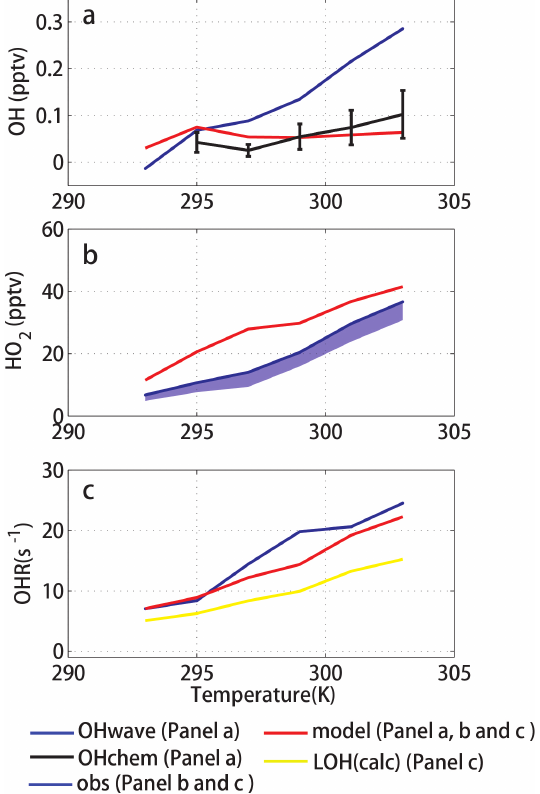
Fig. 5. Temperature dependence of (a) daytime measured and mod- eled OH, (b) daytime measured and modeled HO 2 , and (c) OH re- activity between 9:00 and 15:00PST during BEARPEX09. In (a) , OHwave (blue line), OHchem (black line) and modeled OH (red line) agree at low temperature, but OHwave has a significant tem- perature increase while OHchem and modeled OH show little tem- perature dependence. The vertical bars indicate a combined uncer- tainty as described in Fig. 2. Note that OHchem here is corrected by 0.80 to account for the removal of internal OH by C 3 F 6 addi- tion (see supplemental material). In (b) , measured HO 2 (blue line) is lower than modeled HO 2 (red line) but not significantly at the low and high temperatures. Measured HO 2 may be affected by an RO 2 interference from isoprene, MVK and MACR (Fuchs et al., 2011), as indicated by the blue shading. In (c) , the difference between the measured OH reactivity (blue line) and the OH reactivity calculated from available measurements (yellow line) suggests missing OH re- activity, which is mostly resolved when including modeled interme- diates (red line) in the